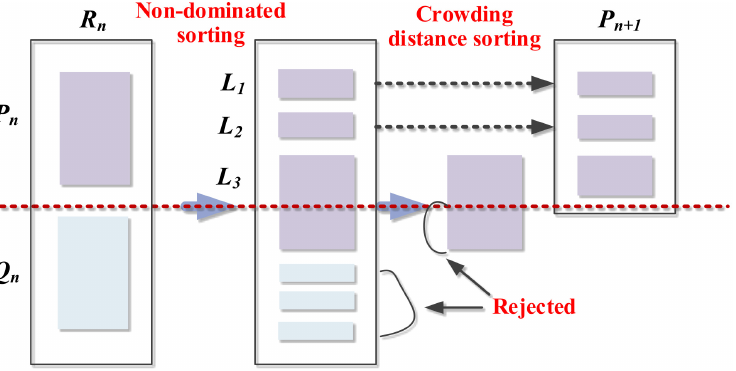
Figure 4. NSGA-II procedure for MOGA showing the different layers of the sorting process